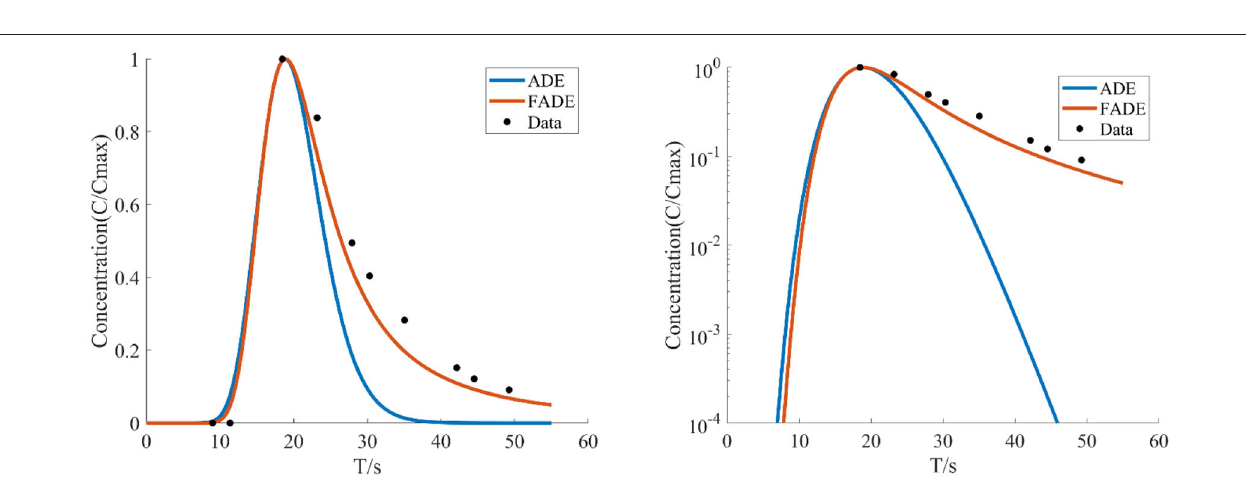
FIGURE 11 | With the average flow velocity v = 22.5909 mm/s, the average fracture width is e = 4.5mm, the concentration of the relative roughness 1 /e is 0.4444 test data, the BTCs are fitted by ADE model and FADE